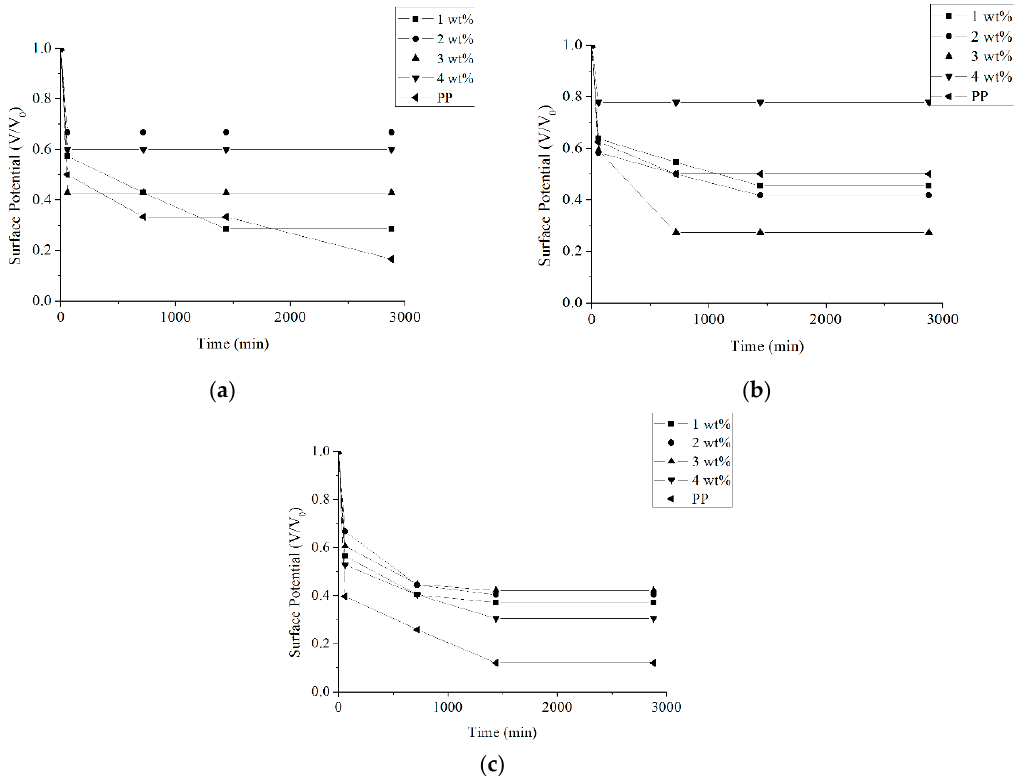
Figure 4. Surface potential of electret melt-blown fabrics as related to the ratio of TiO 2 (1, 2, 3, and 4 wt%) and electric field intensities of ( a ) 1.5, ( b ) 2.0, and ( c ) 2.5 kV/cm.